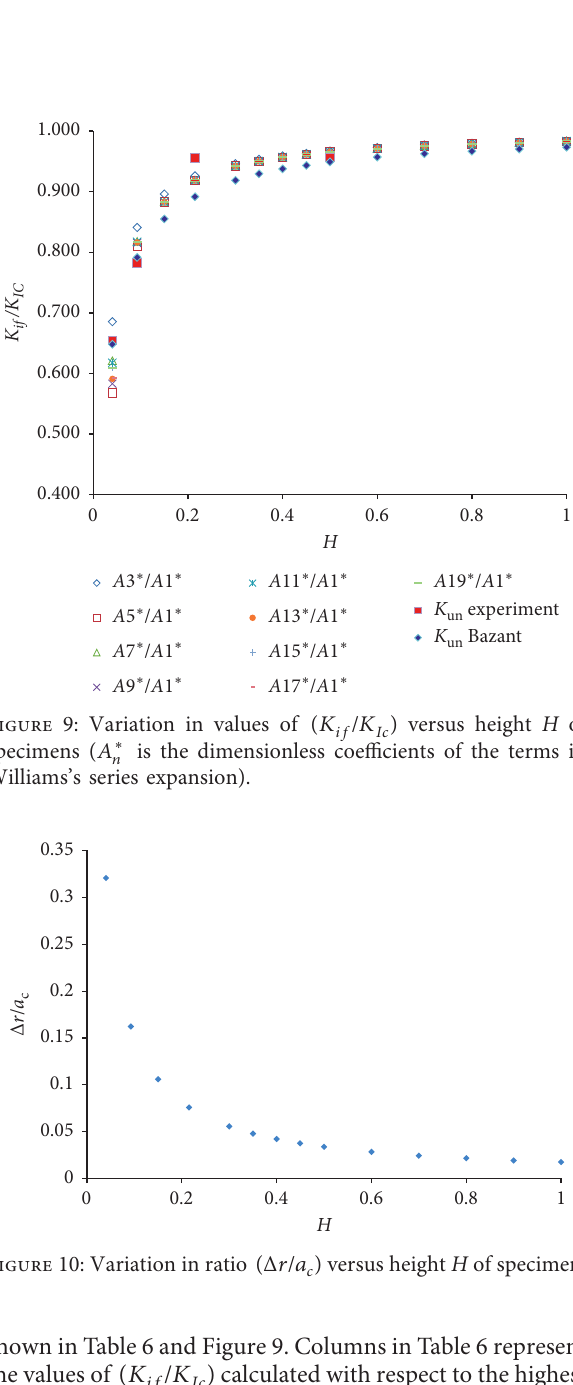
) versus height H of c